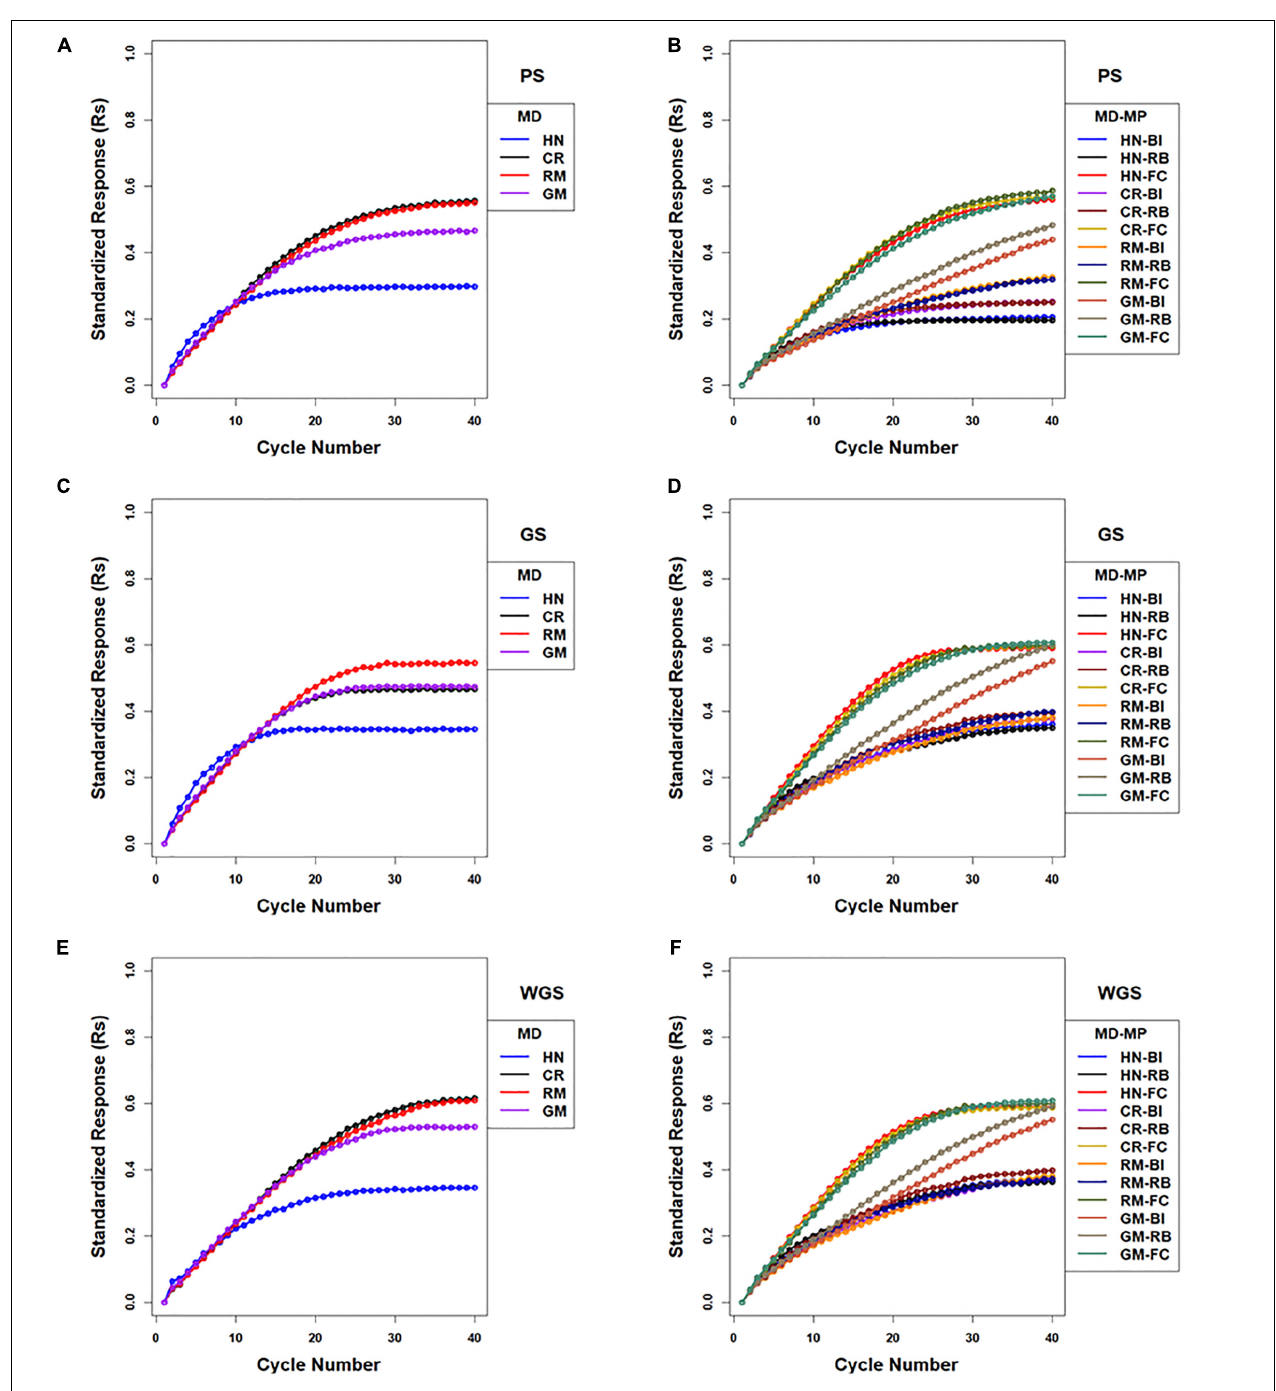
FIGURE 5 | Standardized genotypic responses (Rs) across 40 cycles of recurrent selection on centralized (A,C,E) and family island (B,D,F) populations, using Phenotypic Selection (PS) (A,B) , Genomic Selection (GS) (C,D) and Weighted Genomic Selection (WGS) for the four mating designs (MD): Hub Network (HN), Chain Rule (CR), Random Mating (RM), and Genomic Mating (GM). Standardized genotypic responses are represented from a simulated genetic architecture consisting of 400 additive QTL uniformly distributed throughout the genome and responsible for 70% of phenotypic variability. Ten percent of lines are selected to be used in crosses in HN, CR, RM, and GM designs. Migration policies (MP) included the Best Island (BI), Random Best (RB), and Fully Connected (FC) with bi-directional migrations of two migrants every other cycle. GP models are updated every cycle in GS and WGS using training sets with data from all prior cycles of selection.